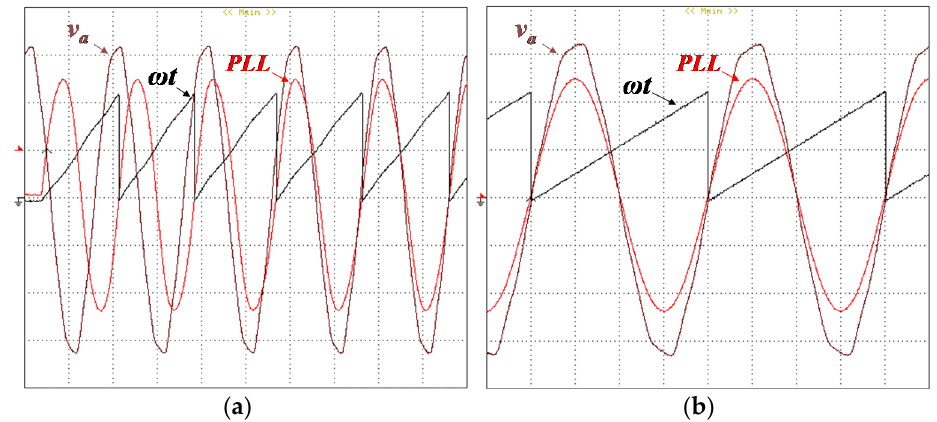
Figure 33. Synchronism with the power grid: ( a ) transient state (voltage: 1 V/div; time: 10 ms/div); ( b ) steady state (voltage: 1 V/div; time: 5 ms/div).